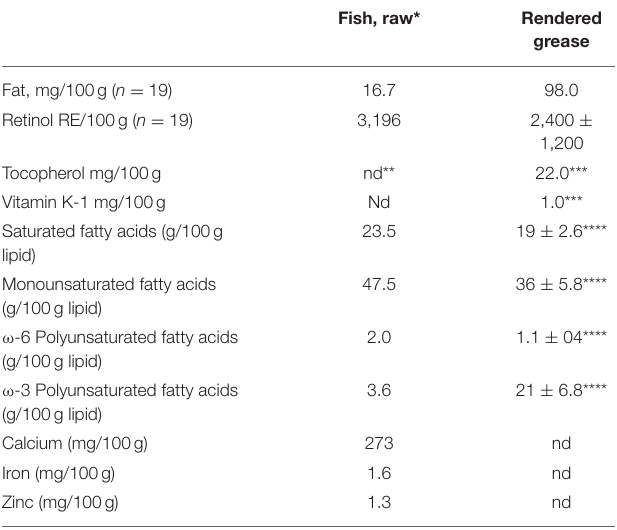
Fish, raw* Rendered grease